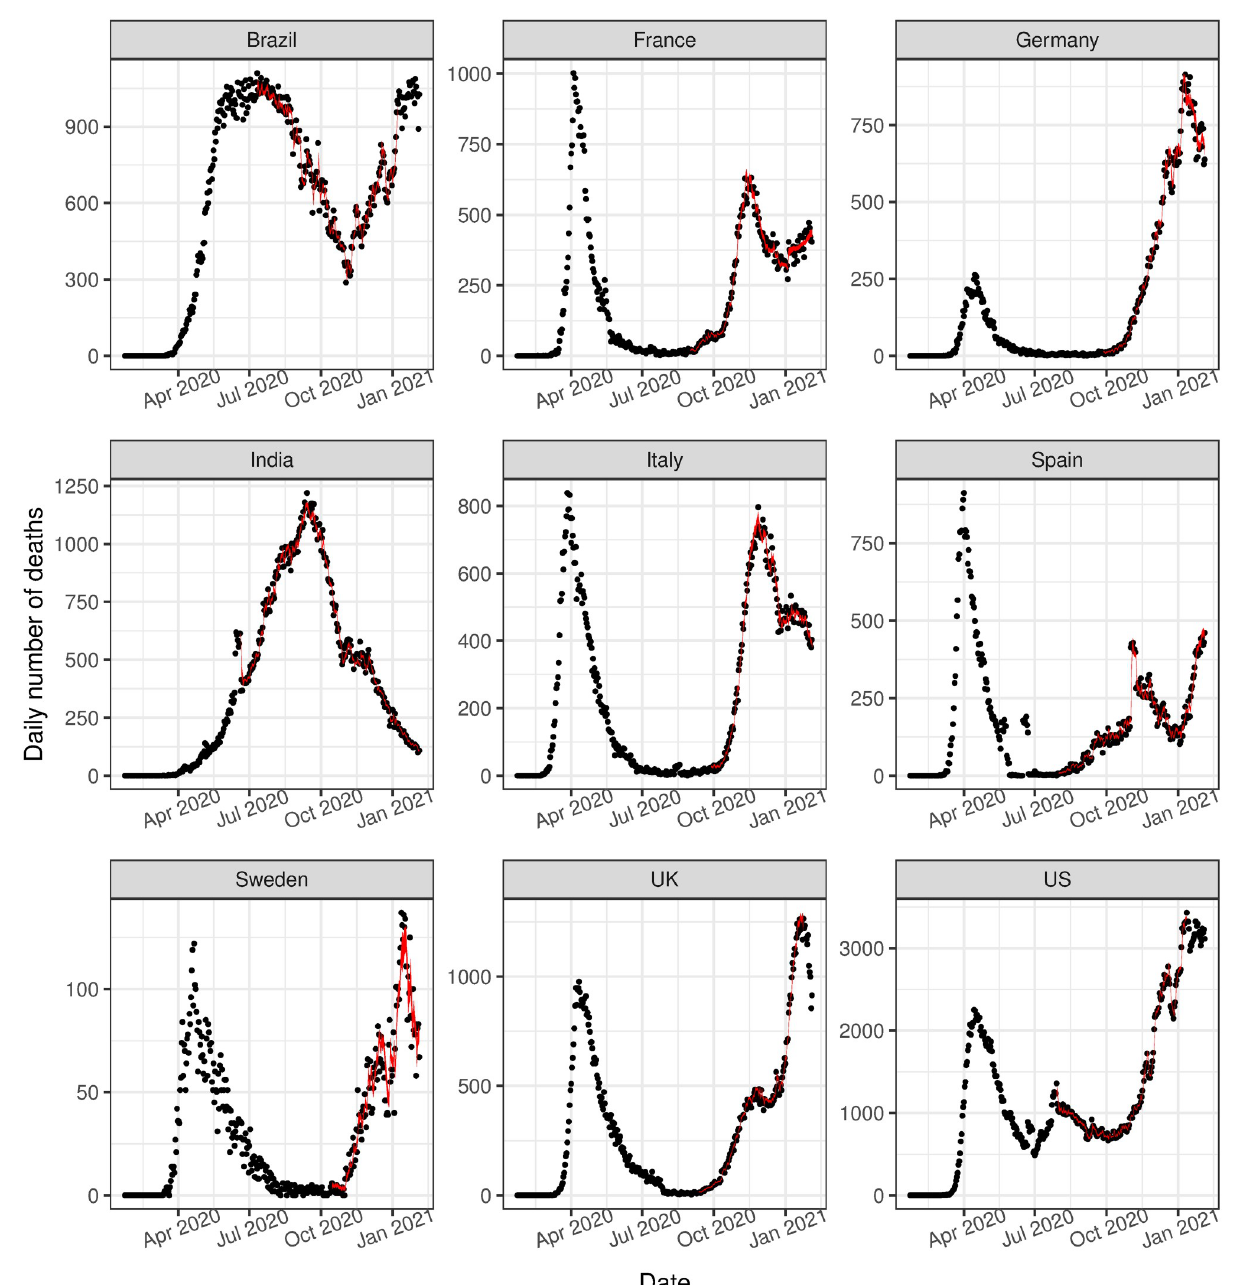
Fig 6. Observed deaths versus estimated deaths (subsequent analysis). The observed number of deaths (black dots) compared to the 95% posterior interval for the estimated expected number of events, i.e. λ ( t ) (solid red ribbon), for the subsequent analysis.